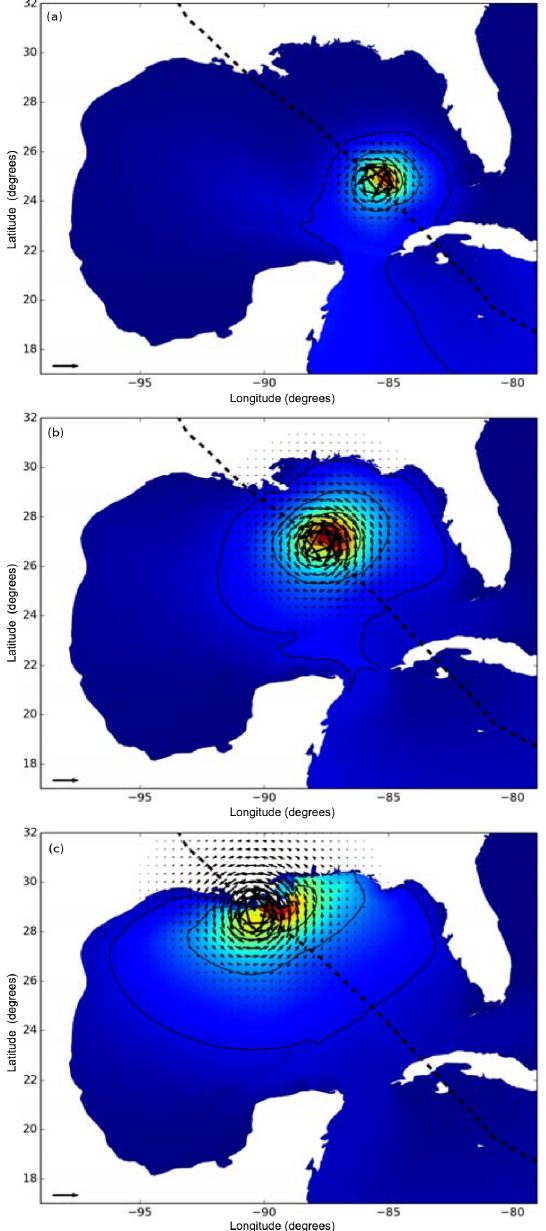
Figure 15. Significant wave heights for hurricane Gustav (2008), calculated using a coupled ADCIRC–SWAN simulation. The sig- nificant wave height field (shading, with contours at 1, 3, 6, 9 and 12m) is shown with the (model) wind field superimposed (arrows, where the arrow on the lower left corresponds to 30ms − 1 ), and the storm track (dashed line). Shown are frames (a) 156, (b) 168 and (c) 180h after start of the simulation (25 August 2008,